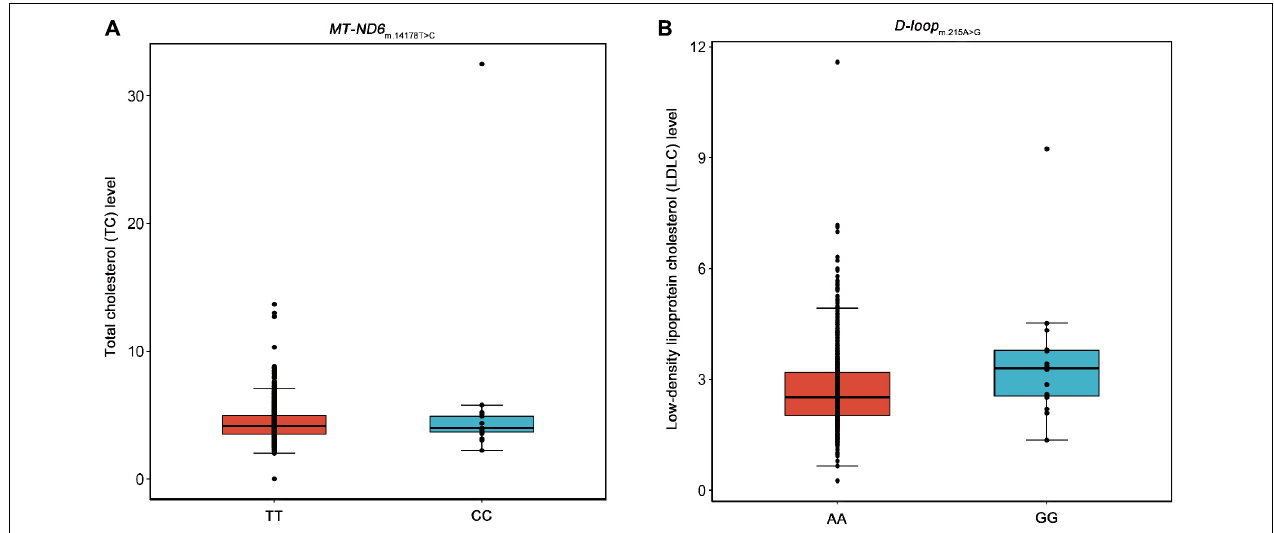
FIGURE 2 | Box plots for the SNPs m.14178T > C and m.215A > G against the levels of TC and LDLC. Five lines from top to bottom for each box were upper extreme, upper quartile, median, lower quartile, and lower extreme. Whiskers were drawn between upper extreme and upper quartile, lower quartile and lower extreme, and the dots above upper extreme or below lower extreme were outliers. (A) The SNP m.14178T > C (T > C) in MT-ND6 against the level of TC. (B) The SNP m.215A > G (A > G) in D-loop against the level of LDLC.